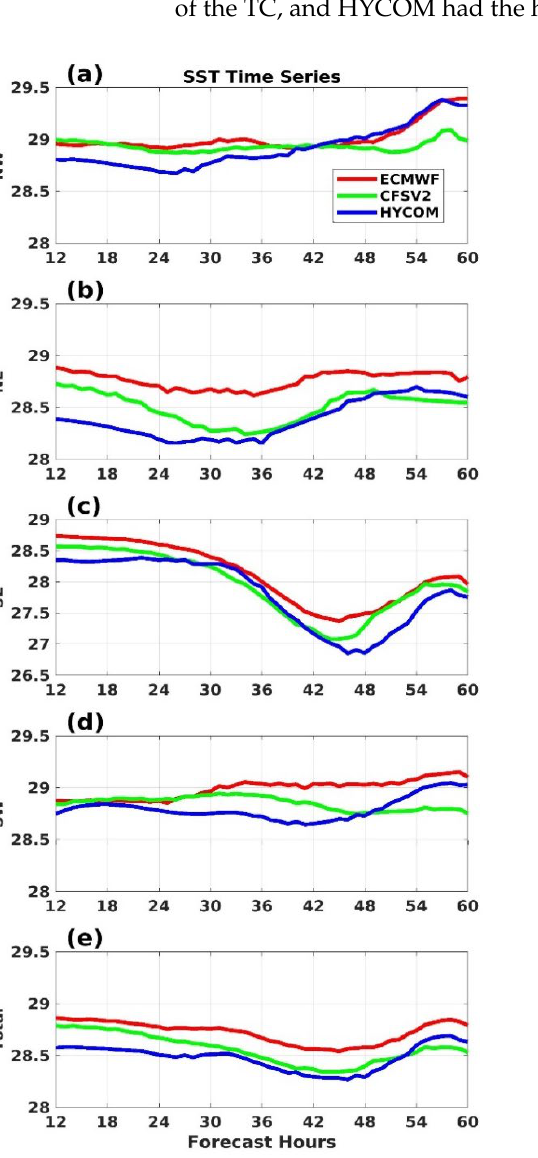
Figure 6. ( a – j ) Time series of quadrant-wise variations in SST (°C) (( a – e ) NW, NE, SE, and SW quadrants and the total VFB. respectively) and enthalpy flux (W.m −2 ) (( f – h ) for the NW, NE, SE, and SW quadrants and the total VFB. respectively) calculated over the VFB from all the experiments.